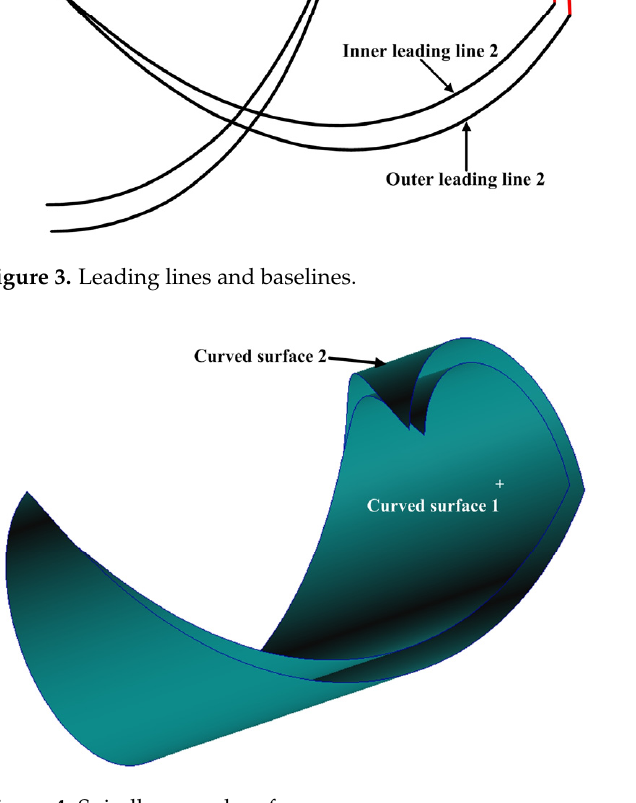
Figure 4. Spirally curved surfaces.